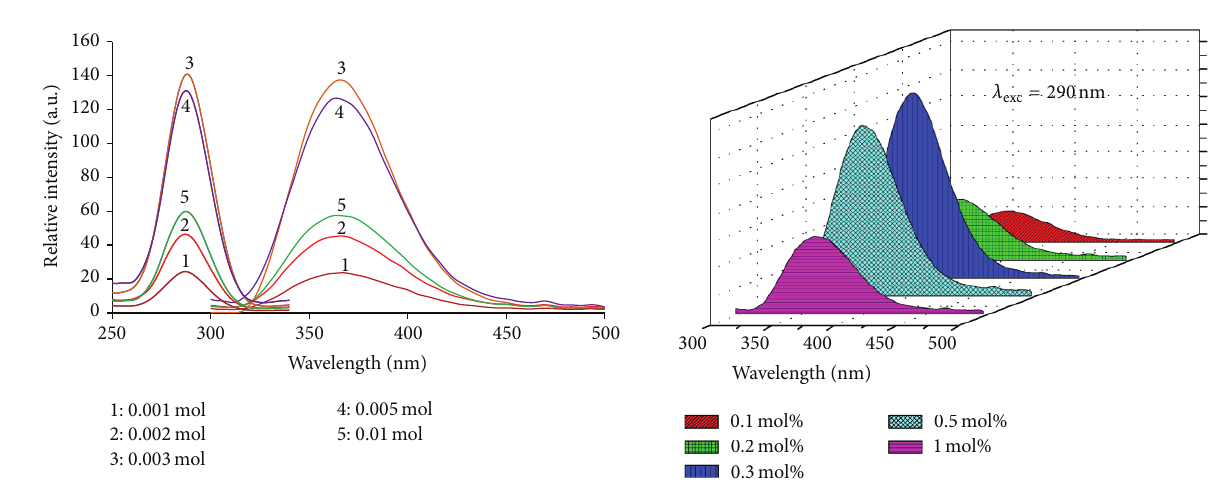
Figure 4: PL and PLE spectra of ( Ca (1−𝑥) Bi 𝑥 ) 0.002, 0.003, 0.005, 0.01), excitation spectra monitored at 365 nm emission, and emission spectra monitored at 290 nm excitation.